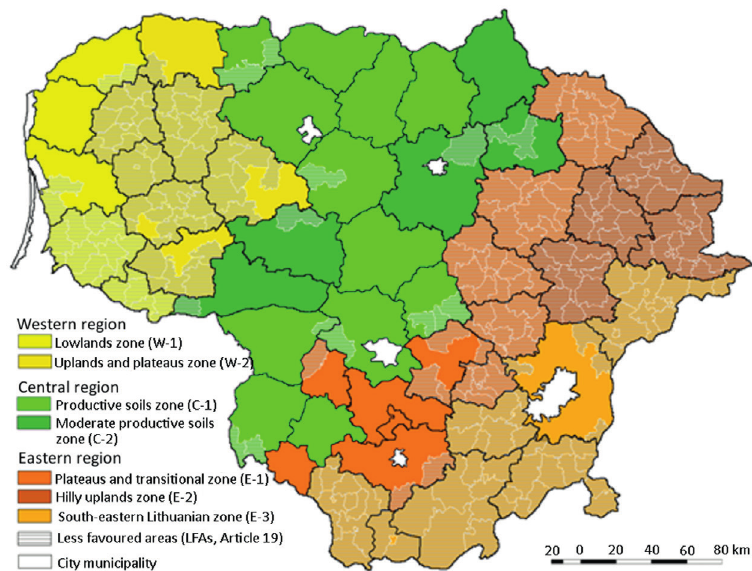
Fig. 1. Agro-ecological regions and zones of